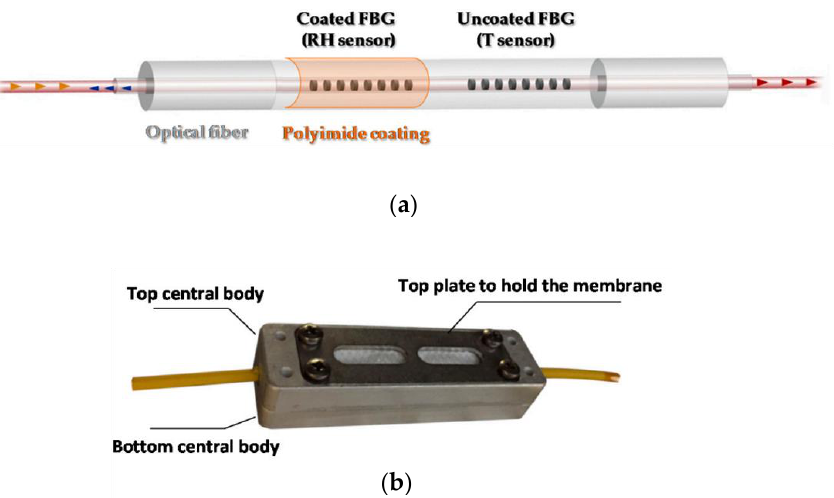
Figure 1. ( a ) Schematic illustration of the proposed fiber optic thermo-hygrometer based on FBG technology. ( b ) Picture of the package developed for the FBG-based thermo-hygrometer (from Ref. [53]).